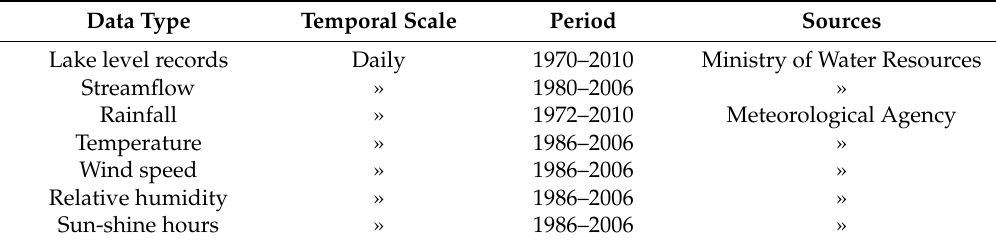
Table 1. The core set of hydro-climatic data employed in the study.